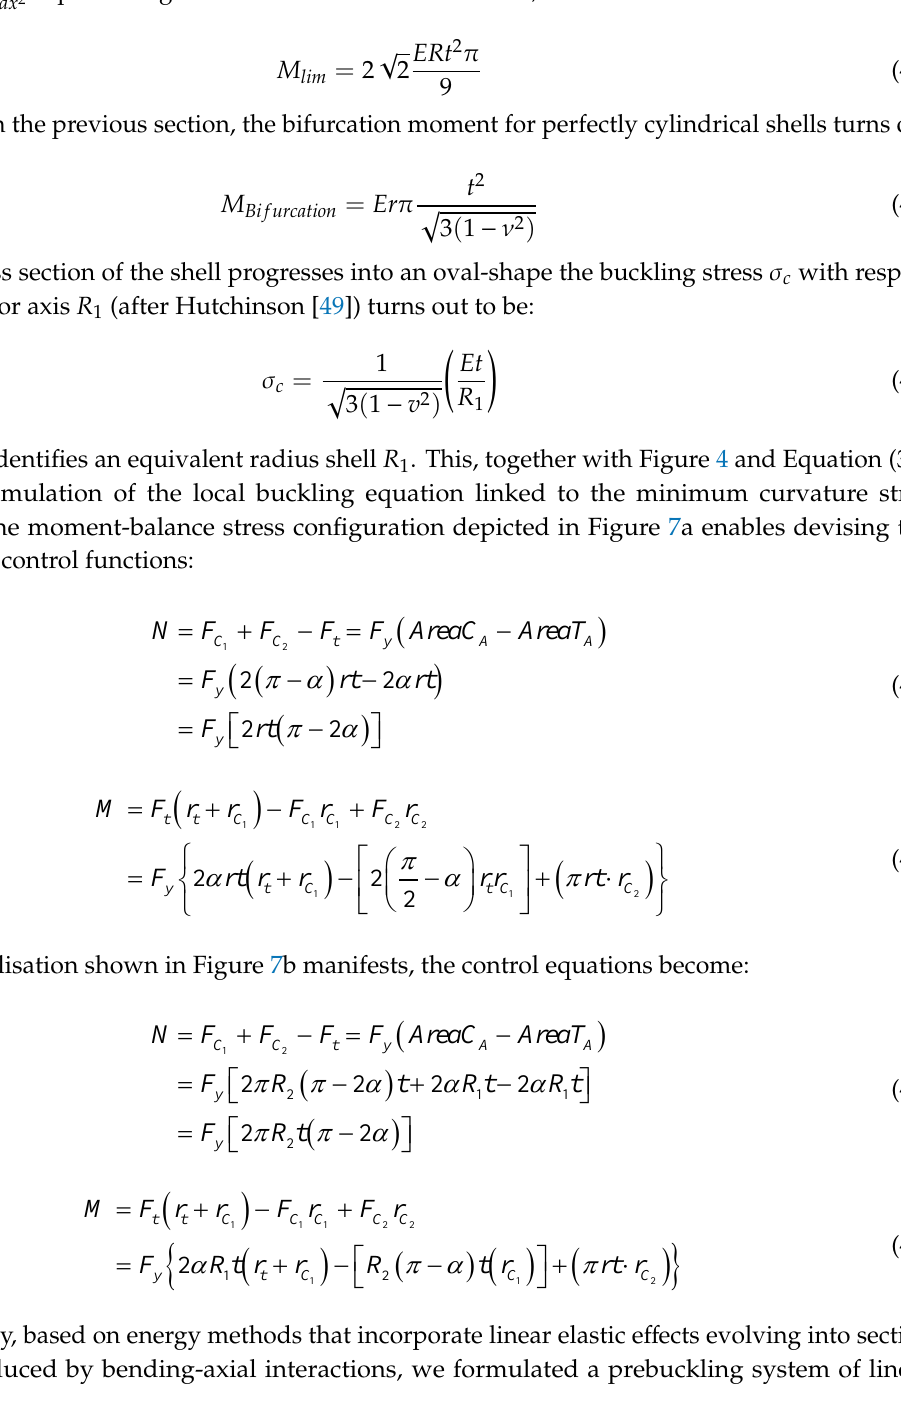
( b ) Figure 7. Loading conditions of undeformed and ovalised shell cross sections, ( a ) tubular shell cross section without ovalisation and ( b ) ovalised tubular shell cross section. As the ovalisation shown in Figure 7b manifests, the control equations become: 